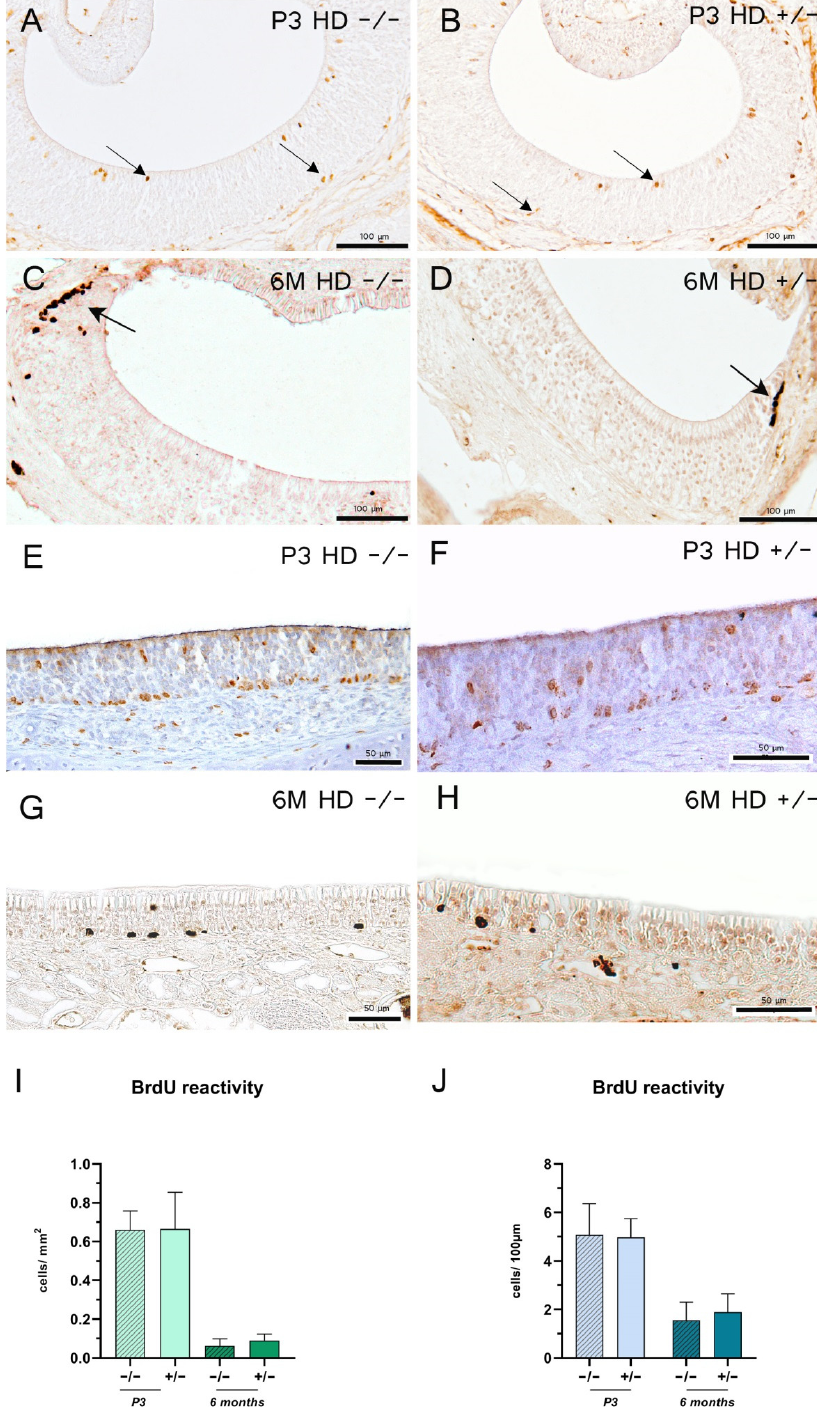
Figure 3. 5-Bromo-2 (cid:48) -deoxy-uridine (BrdU) detection of 3-day-old (P3) and 6-month-old (6 M) rats 2 h post-injection. ( A – H ) Representative immunohistochemical reaction of BrdU-positive cells in the vomeronasal epithelium ( A – D ) and main olfactory epithelium ( E – H ); arrows indicate BrdU-positive cells. Scale bars: ( A – D ) 100 µ m; ( E – H ) 50 µ m. Column bars show BrdU reactive cell counts per mm 2 ( I ) or per 100 µ m ( J ); n = 6; ( J ) +/ − 6 M: n = 5. The significance of differences between groups was tested with mixed-effects analysis followed by Bonferroni’s multiple comparisons (age x genotype interaction: ( I ) F value = 0.07894, degree of freedom = 1; ( J ) F value = 1.785, degree of freedom = 1. Data are presented as means ± SD and statistical significance was set at p <